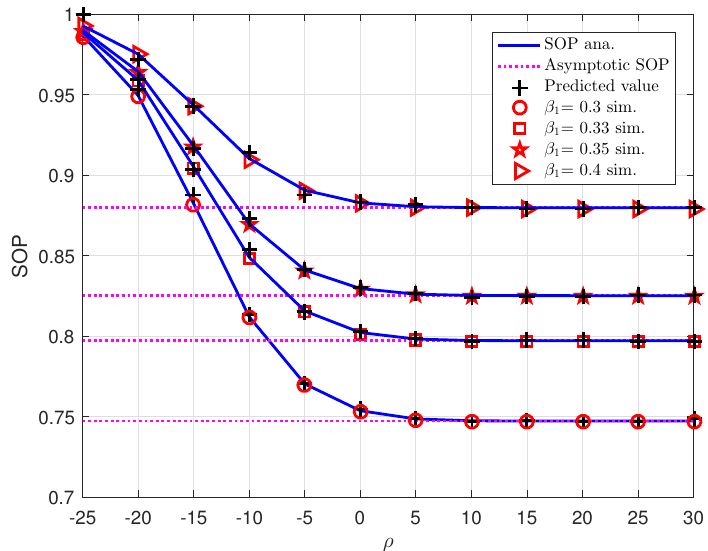
Figure 7. SOP versus ρ for different β 1